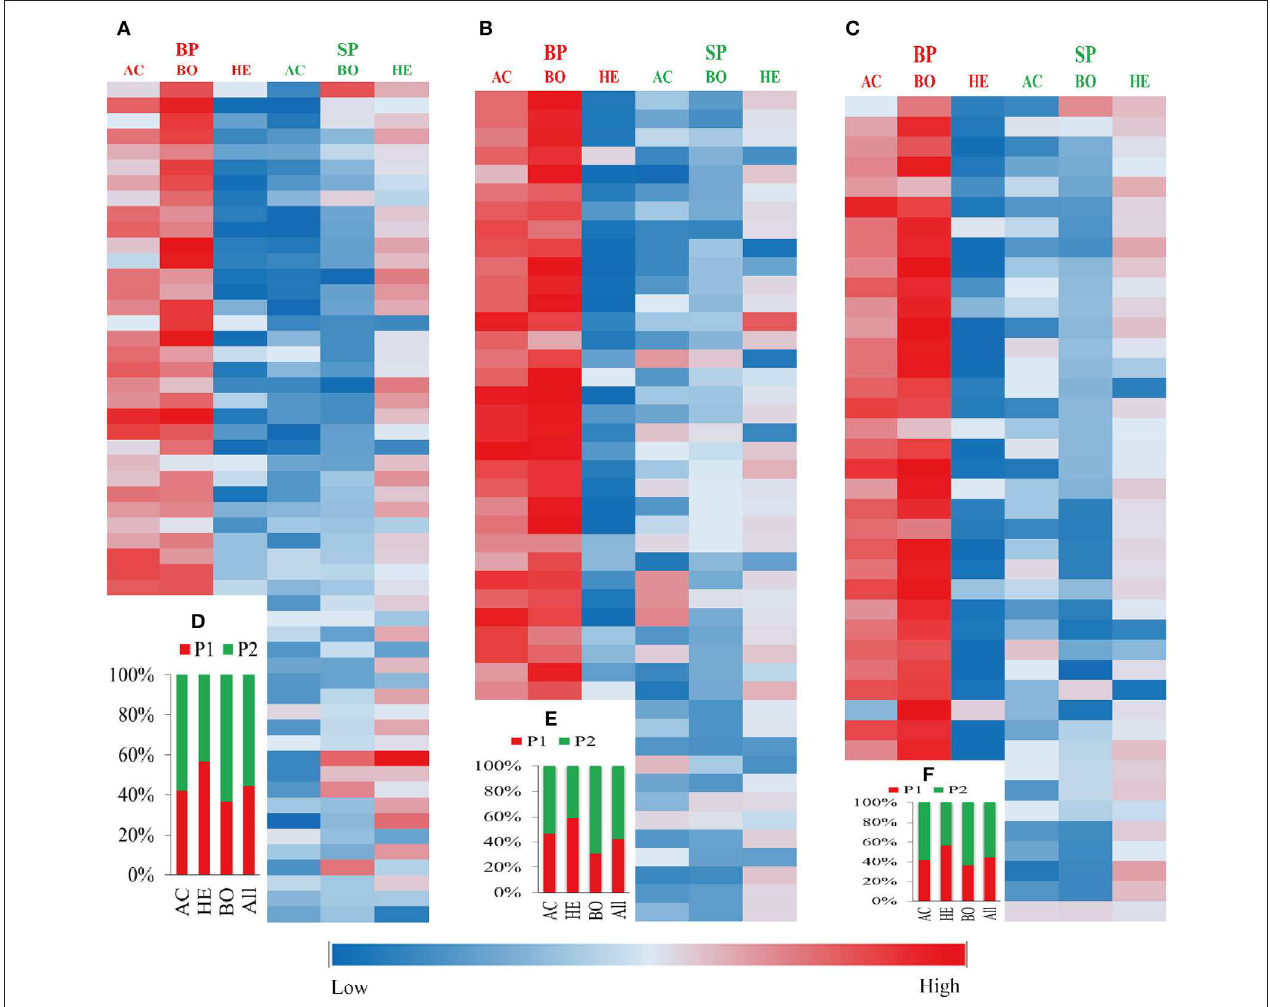
FIGURE 7 | Relationship between personality classification and different personality characteristics of swimming crab. The result is based on the clustering considering all the three factors. P1 is the brave individual; P2 is the shy individual; AC is activity; HE is hesitancy; BO is boldness. (A–C) The results of starvation for 0, 6, and 12 days. Each square represents an individual animal. For a personality characteristic, the more the color tends to red, the stronger the personality characteristics numerically; the more the color tends to blue, the weaker the personality characteristics numerically. (D) Personality proportion under 0 day starvation. (E) Personality proportion under 6 days starvation. (F) Personality proportion under 12 days